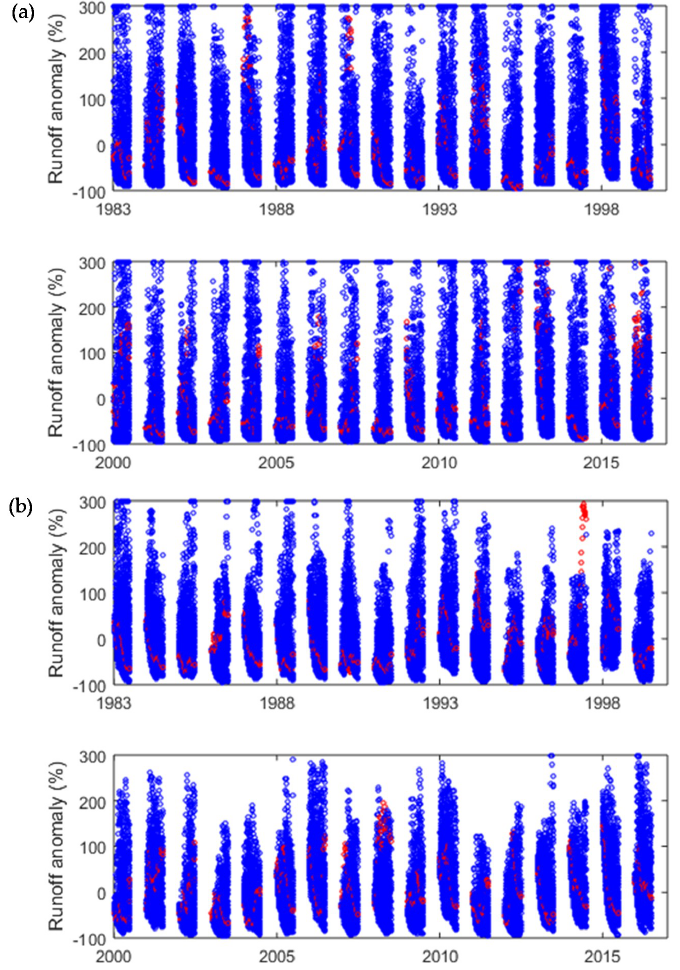
Figure 4. Daily ensemble runoff reforecast (blue dots) and observations (red dots) for ( a ) the Yiluo River and ( b ) the Beijiang River during Period1 1983–2016. River and ( b ) the Beijiang River during Period1